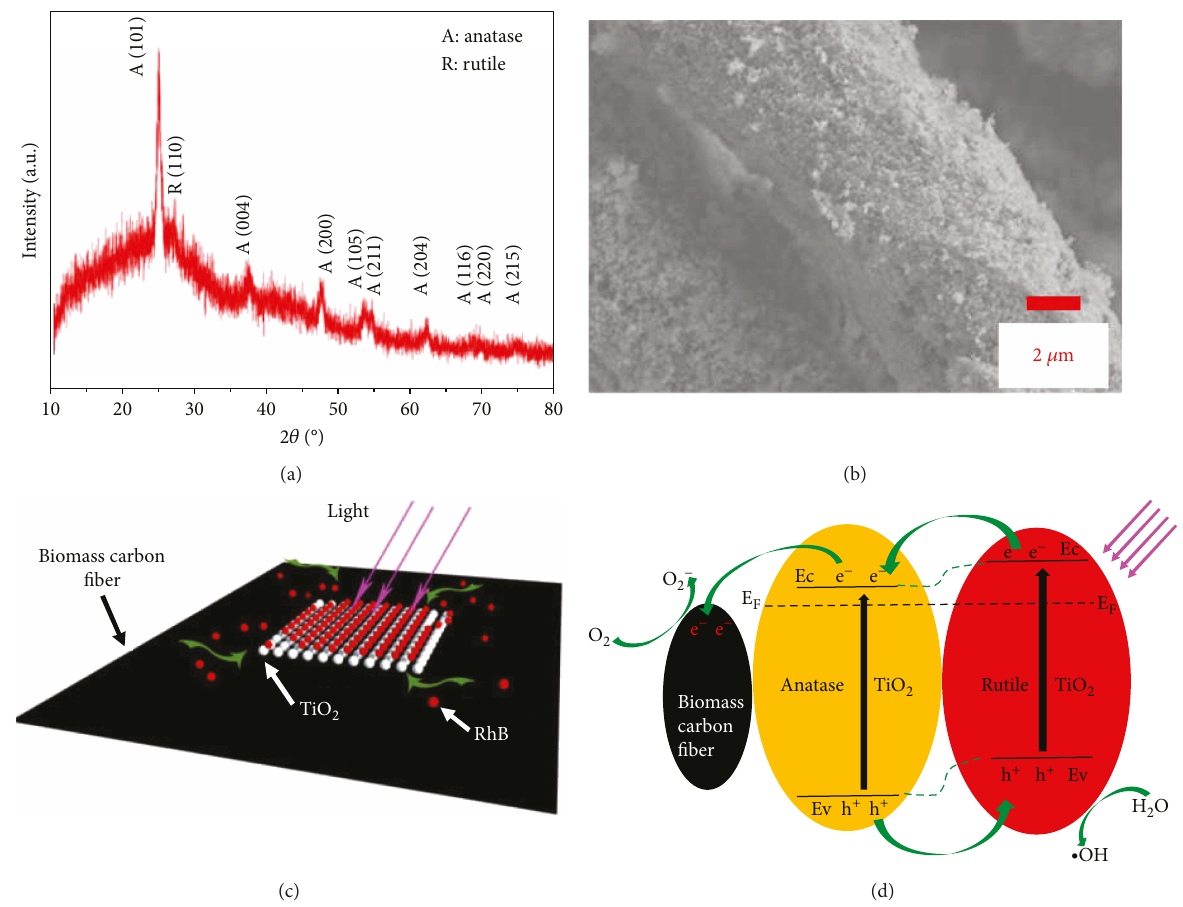
Figure 7: XRD pattern (a) and SEM (b) image of TCF15 after the photocatalytic degradation cycle. (c, d) Photocatalytic reaction mechanism